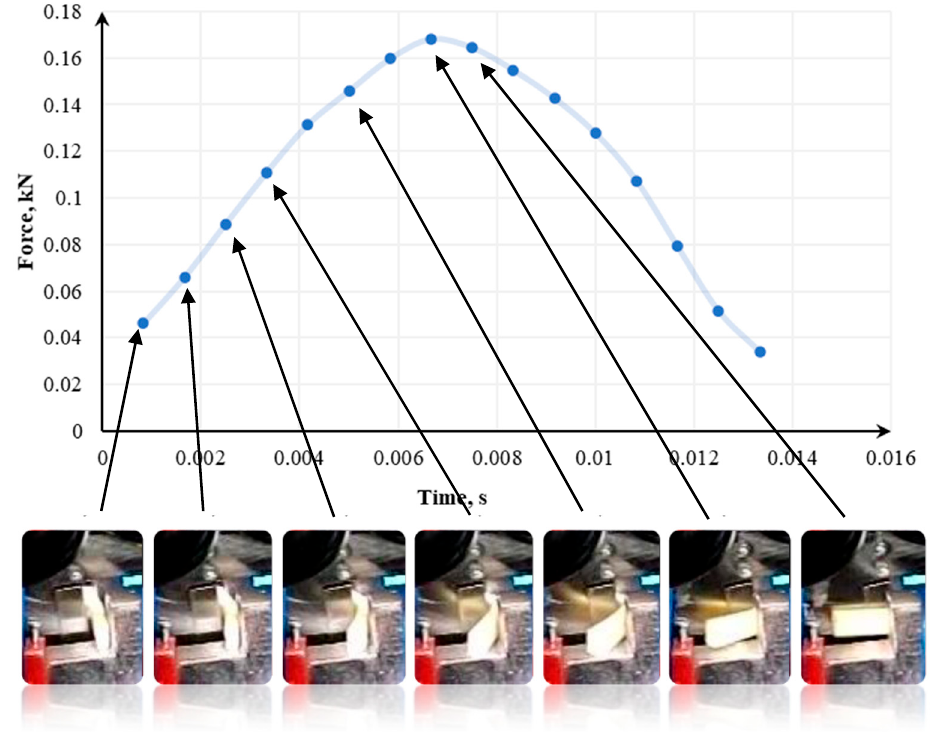
Figure 15. Momentary force values during grinding of a single polypropylene sample in a vertical arrangement using a 60° knife.